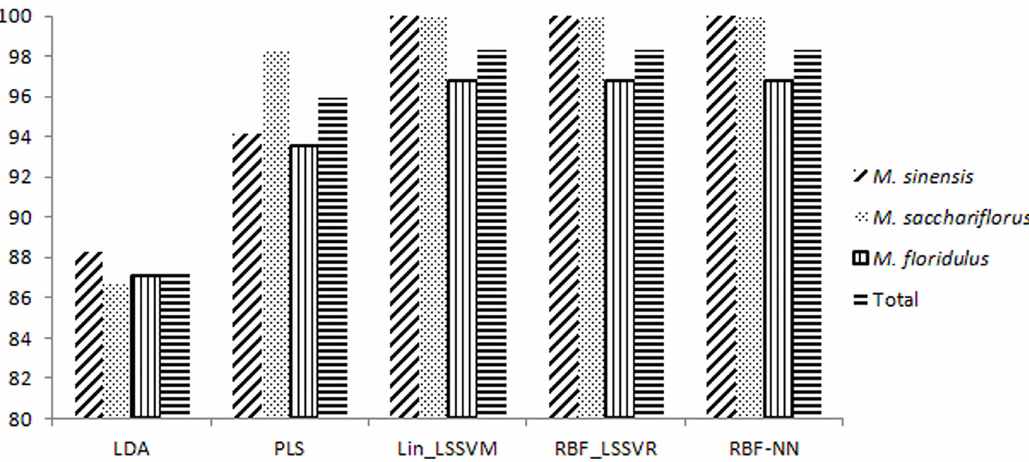
Fig 3. The bar chart of five calculation models for M . sinensis , M . sacchariflorus and M . fIoridulus .